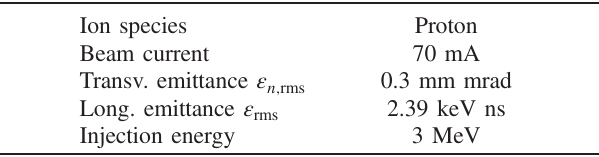
TABLE I. Beam input parameters of the 65 MV proton